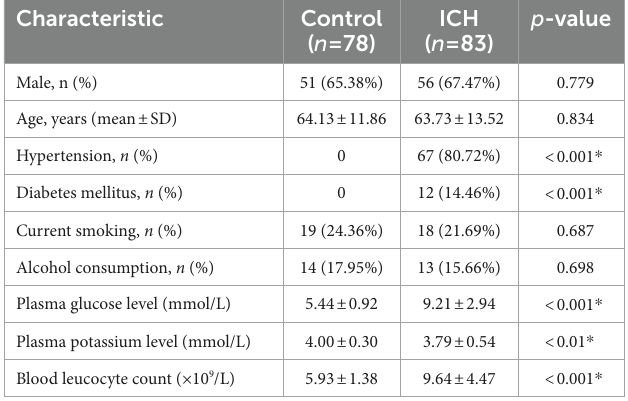
TABLE 1 Demographic data and vascular risk factors of the intracerebral hemorrhage (ICH) patients and control patients in this study. Characteristic Control